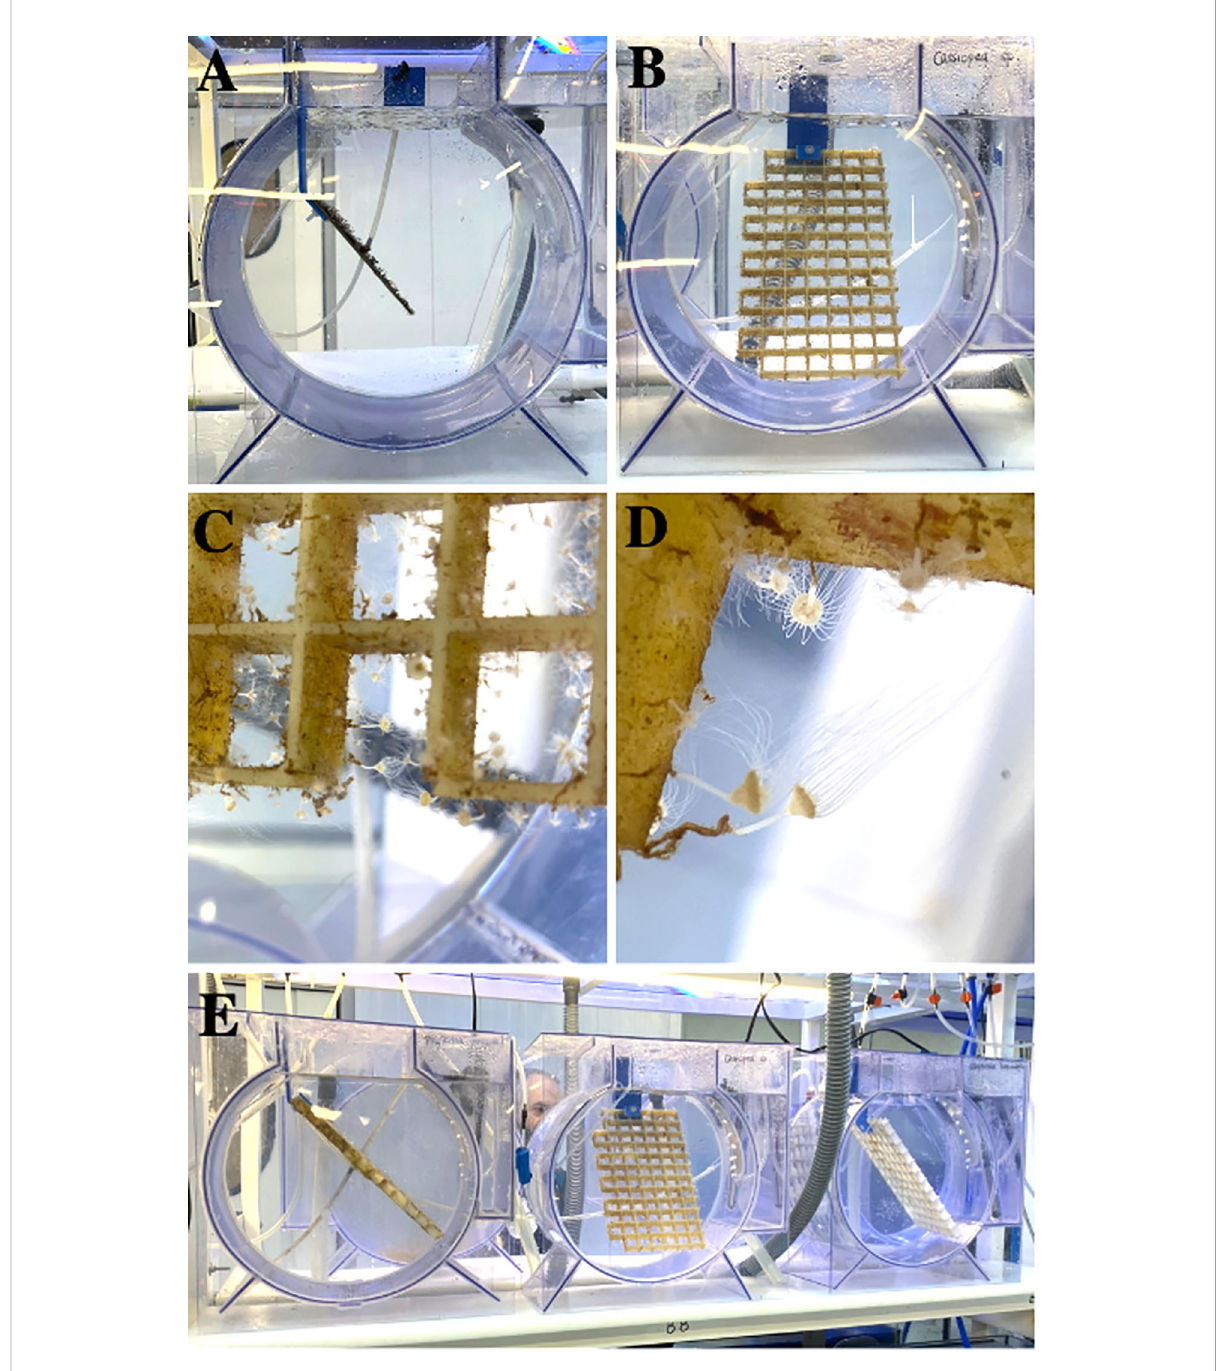
FIGURE 3 Polyp plates in fl ow-through aquarium: (A) Polyp plate of Aurelia spp. (B) Grid polyp plate of Cassiopea spp. (C) Suspended polyps in a downward or sideways position, enhancing prey capture, strobilae formation and release of ephyrae. (D) Tentacles of Cassiopea spp. polyps fully extended. (E) Polyp plates with Phyllorhiza punctata (left), Cassiopea spp. (middle) and Cotylorhiza tuberculata (right) species. Notes: The Cassiopea spp. polyp plates can be placed in rectangular tanks; The use of grid plates prevents the massive growth of algae; Multiple polyp plates can be placed in the same